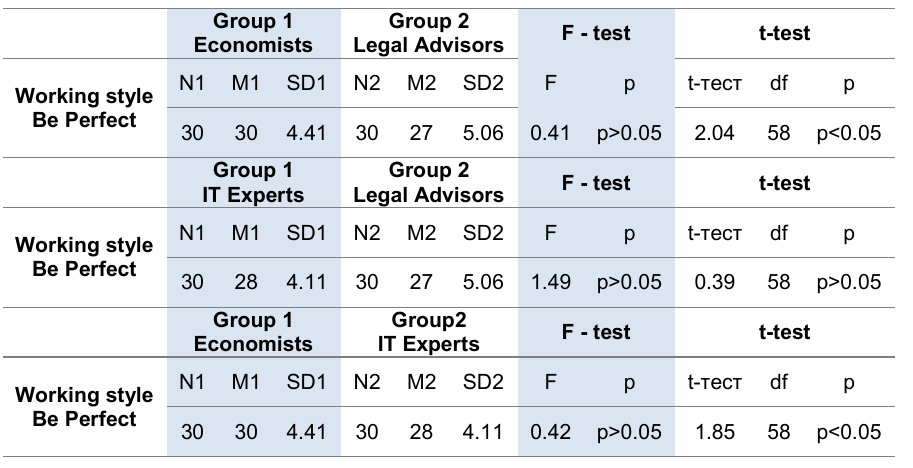
Table 4: Analysis of the differences between the three professions regarding the working style Be Perfect